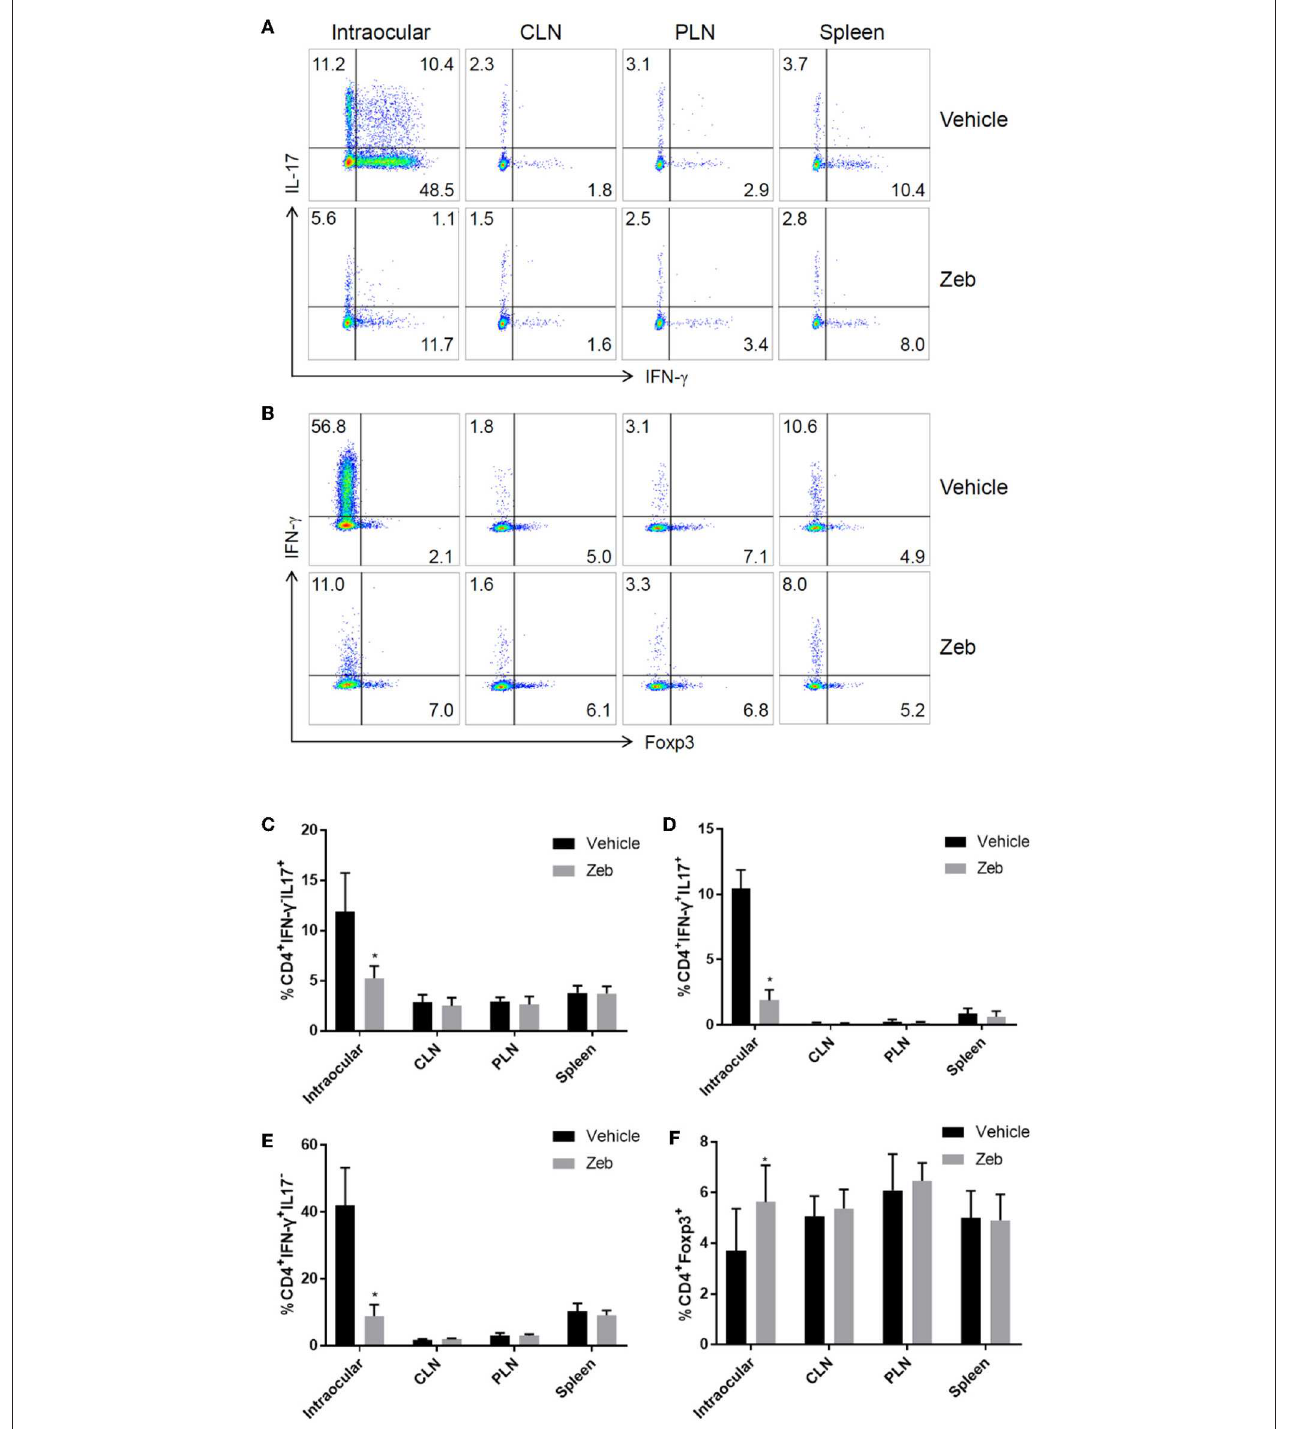
FIGURE 8 | Analysis of CD4 + T cells in inflamed eyes, as well as lymph nodes. (A,B) The representative FACS analysis of the frequency of IFN- γ + , IL-17 + , and Foxp3 + cells in single cell suspensions (pooled from 5 mice) prepared from the eyes, cervical lymph nodes (CLN), peripheral lymph nodes (PLN), and spleens of EAU mice treated with ( N = 5) or without zebularine ( N = 5) on Day 14 post-immunization. (C–F) Summary of two analysis (total of 10 EAU mice treated with zebularine and 10 without zebularine) of the frequency of IFN- γ + , IL-17 + , and Foxp3 + cells in eyes and lymph nodes (each analysis represented the pooled cell population from 5 mice per group). * P < 0.05, paired T test (student